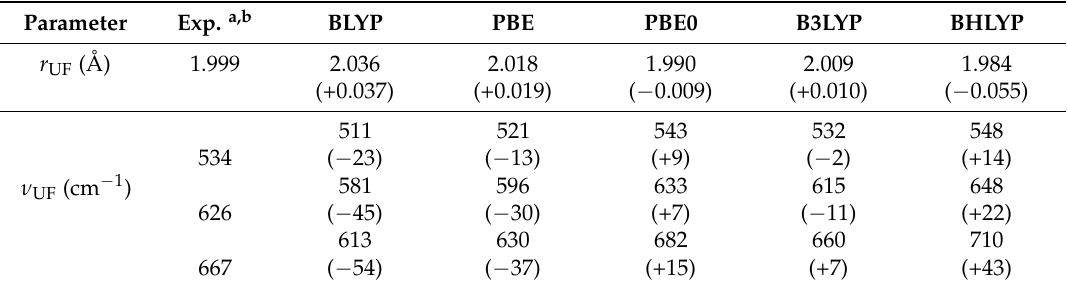
Calculated structural and vibrational parameters of UF 6 calculated with various exchange-correlation functionals. Values in parenthesis indicate deviations from experimental values. a ref [64], b ref.